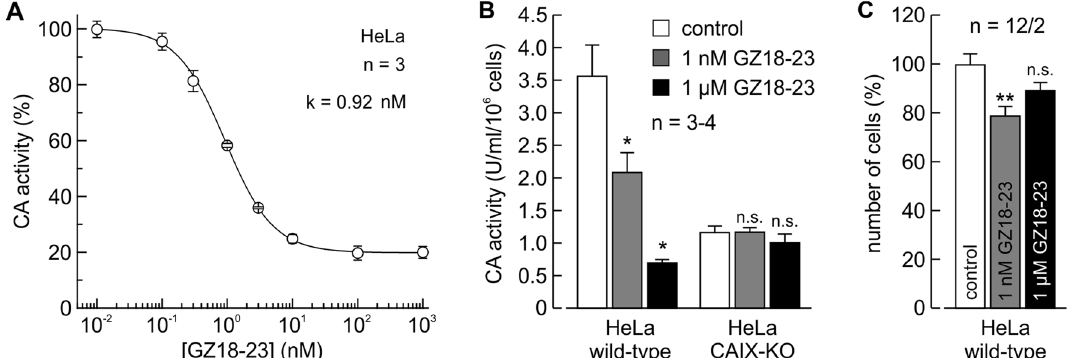
Figure 7. Inhibition of CA enzymatic activity by GZ18-23 in live hypoxic HeLa WT and CAIX-KO cell cultures by gas-analysis mass spectrometry. ( A ) Inhibition of CA activity by the inhibitor GZ18-23 in hypoxic HeLa cells. ( B ) Comparison of CA activity by gas-analysis MS of hypoxic HeLa WT and CAIX-KO cell cultures. ( C ) Viability of hypoxic HeLa cells upon application of the GZ18-23